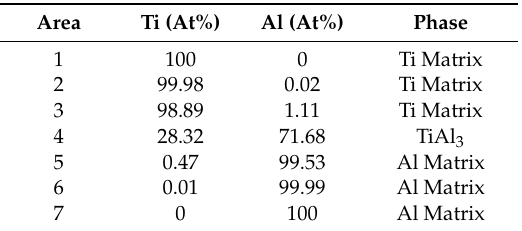
Figure 6. Energy-dispersive X-ray spectroscopy (EDS) analysis in bonding layer of the Ti/Al laminated composites in 45° direction. Table 1. The phase near the interface of the Ti / Al laminated composites.